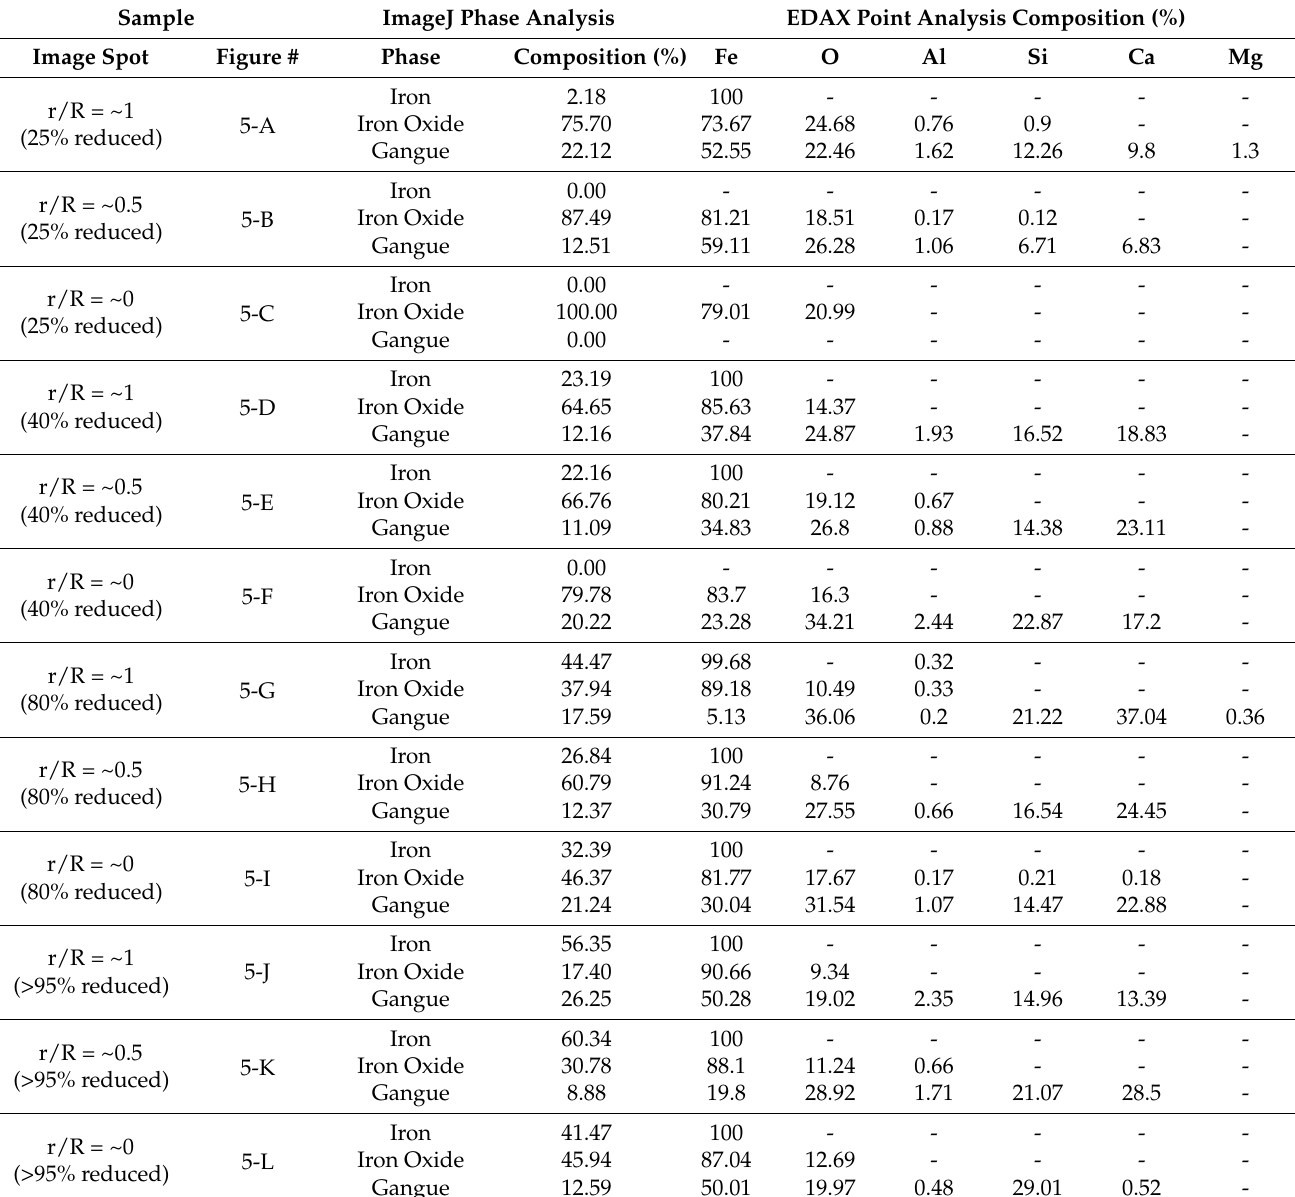
Table A2. Phase analysis and EDAX point analysis for SEM images (Enerigon III gas